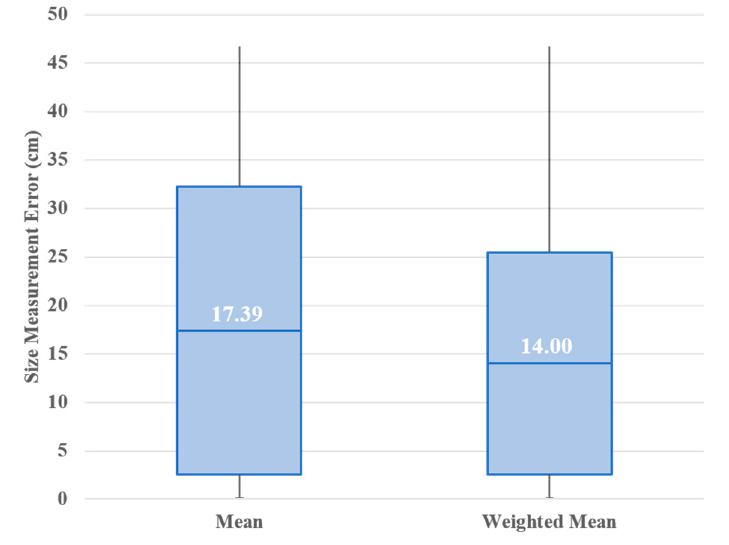
Figure 10. Result evaluation for anomaly size estimation.